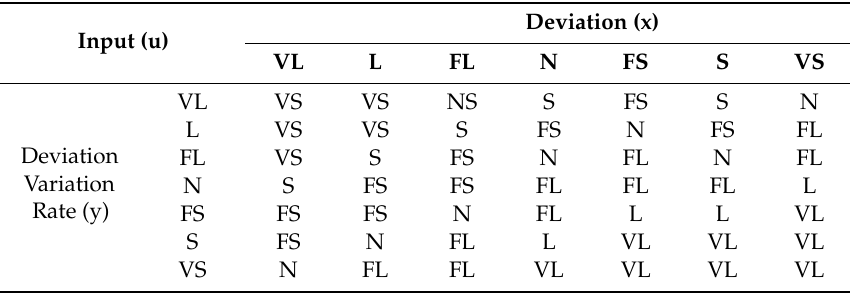
Table 2. Rules table for language variables.